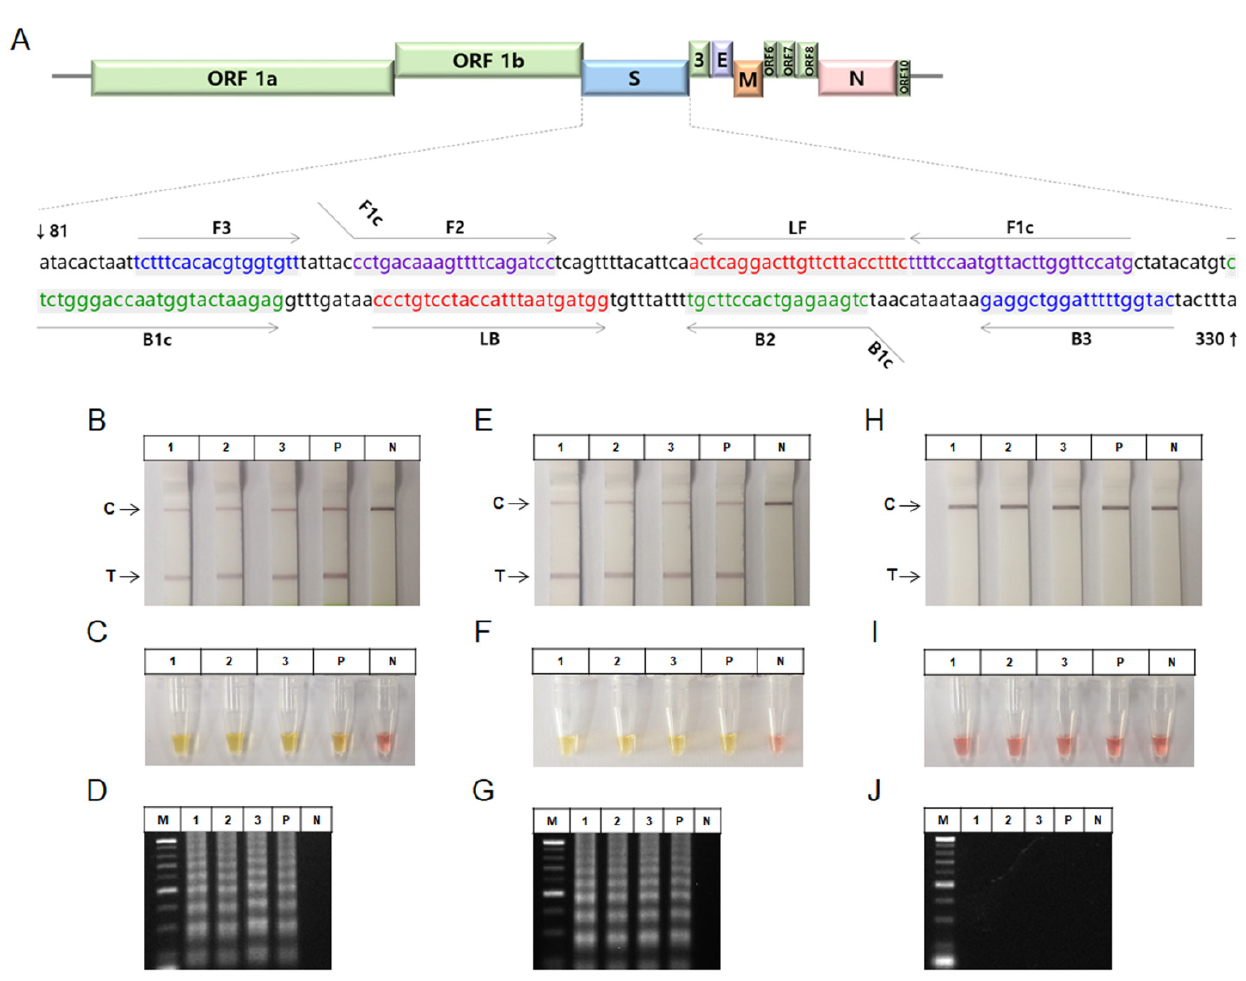
Figure 5. Sensitivity of RT-LAMP assay for SARS-CoV-2 detection. ( A ) SARS-CoV-2 S gene sequences and RT-LAMP primer designing. Available sequences were aligned to design primer sets that target the S gene. The locations that LAMP primers (F3, B3, FIP, BIP, LF, and LB) recognize on the S gene were highlighted. ( B – J ) RT-LAMP assay was performed using synthetic RNA (5.85 × 10 9 to 5.85 × 10 7 per reaction) for the S gene of SARS-CoV-2. ( B – G ) Assessment of the sensitivity of the RT-LAMP assay using a LAMP primer set comprising F3, B3, FIP, BIP, LF, and LB primers that recognize the S gene of SARS-CoV-2. RT-LAMP assay was performed for ( B – D ) 30 and ( E – G ) 60 min at 65 ◦ C. ( B , E ) RT-LAMP with LFA, ( C , F ) colorimetric RT-LAMP, and ( D , G ) agarose gel electrophoresis of the reaction products. ( H – J ) Assessment of the sensitivity of the RT-LAMP assay by using only LF and LB primers. The RT-LAMP assays were performed at 65 ◦ C. ( H ) RT-LAMP with LFA, ( I ) colorimetric RT-LAMP, and ( J ) agarose gel electrophoresis of the reaction products. RT, reverse transcription; LAMP, loop-mediated isothermal amplification; S, spike; LFA, lateral flow assay; M, size marker; P, positive control; N; negative control; T, target; C, control.